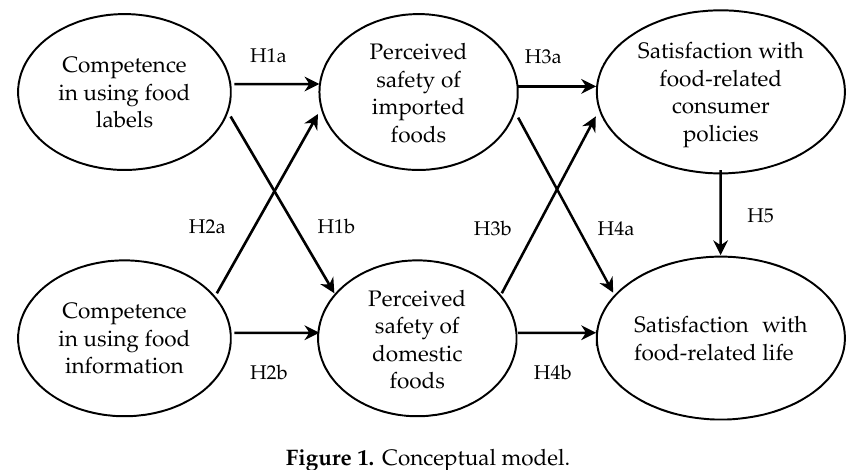
Figure 1. Conceptual model.